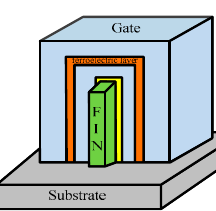
Figure 7. Negative capacitance-based FinFET with ferroelectric layer as dielectric [40].